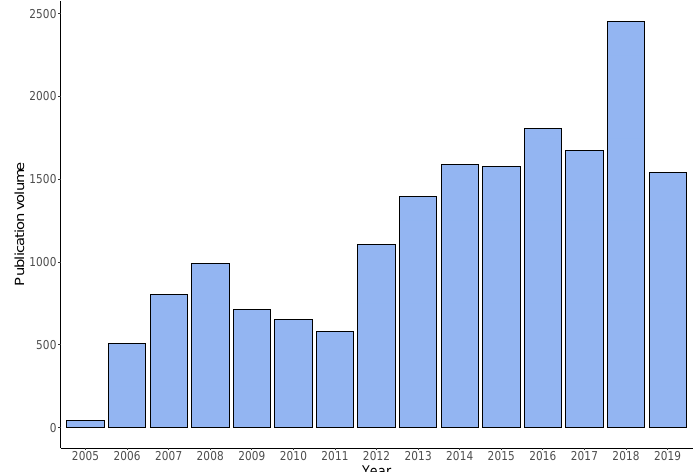
Figure 2. Publication volume in each year from 2005 to 2019.